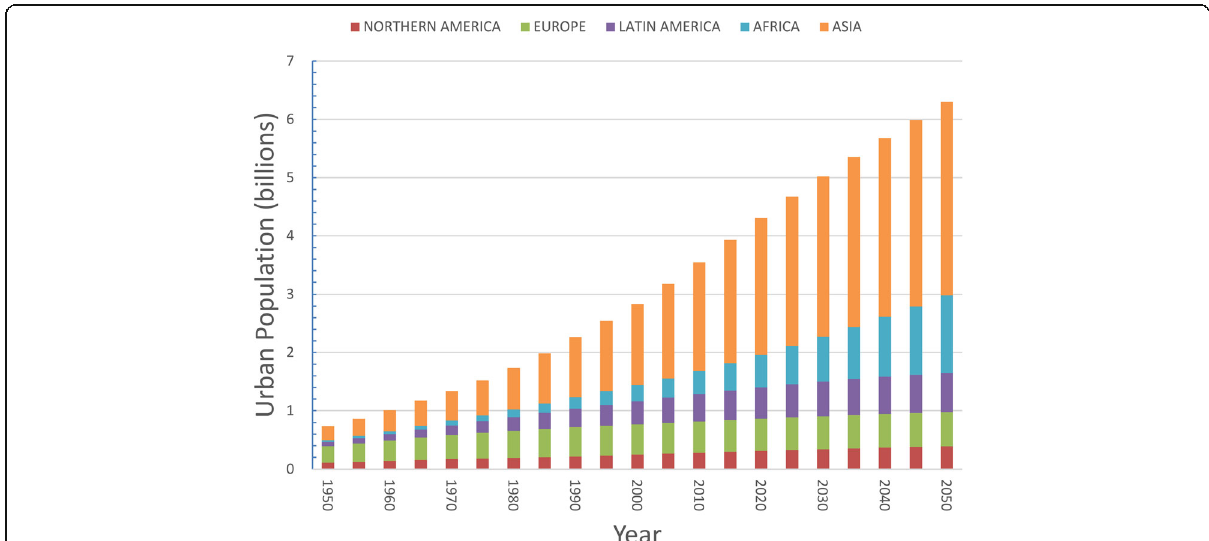
Fig. 1 Urban growth over time. Total urban population, by region, as estimated and forecast by the UNPD World Urbanization Prospect dataset (2014). Note that the Latin America region includes the Caribbean. Note also that Oceania, including Australia and New Zealand have relatively few urban dwellers (42 million) and are not shown on this